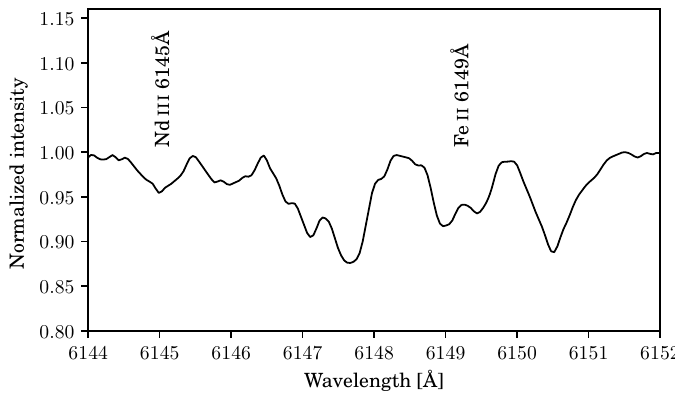
Figure 1. A portion of an echelle spectrum of HD6757 showing the Zeeman splitting caused by the magnetic